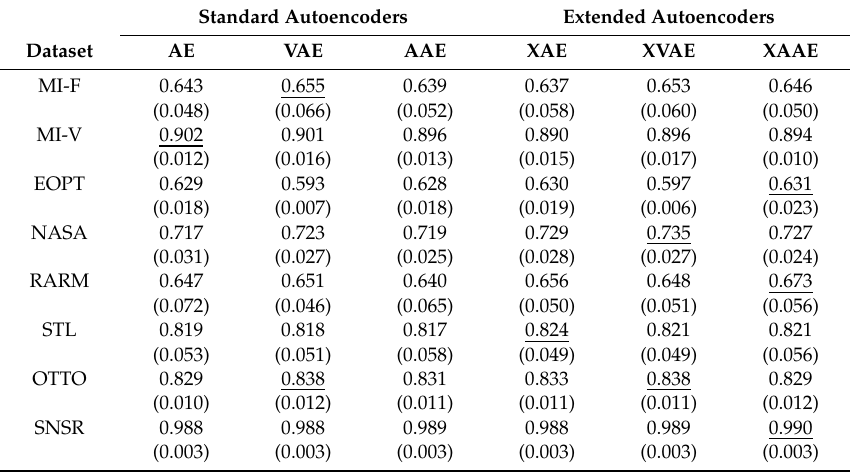
Table 2. The AUROC (area under the receiver operating characteristic curve) of RaPP with novelty datasets. The best cases are underlined for each dataset, and the number of in parenthesis indicates the standard